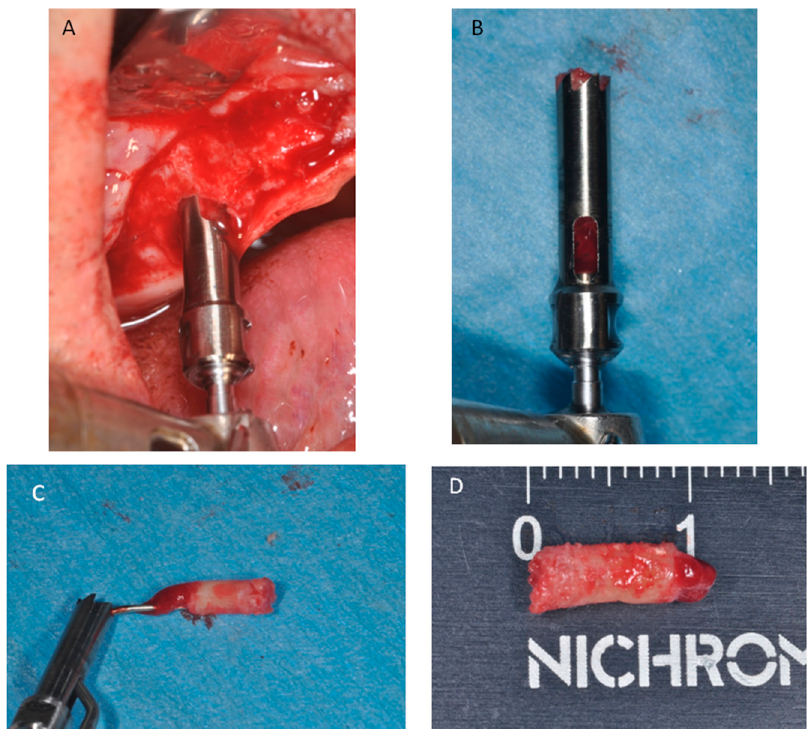
Figure 12. ( A ) After six months of healing a small trephine was used. ( B ) To retrieve a biopsy. ( C ) The bone core was removed from the trephine. ( D ) Bone core biopsy carried out.